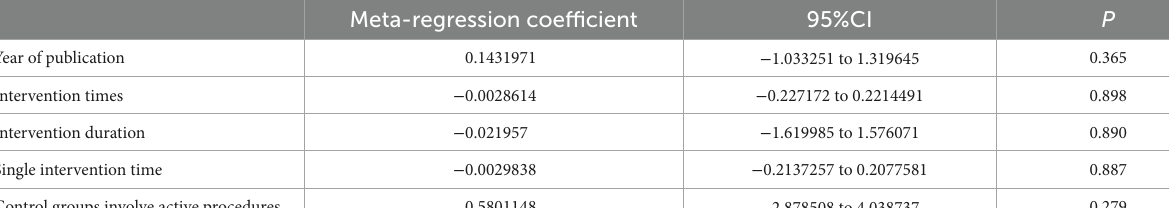
TABLE 3 Meta-regression analysis of potential moderators TMT to explain heterogeneity of older people with cognitive impairment.